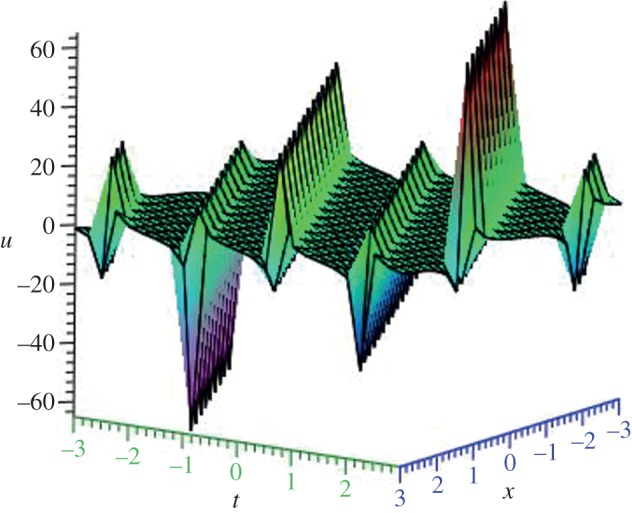
Periodic solution u18(ξ) of mKdV equation for δ=1 and k=1.